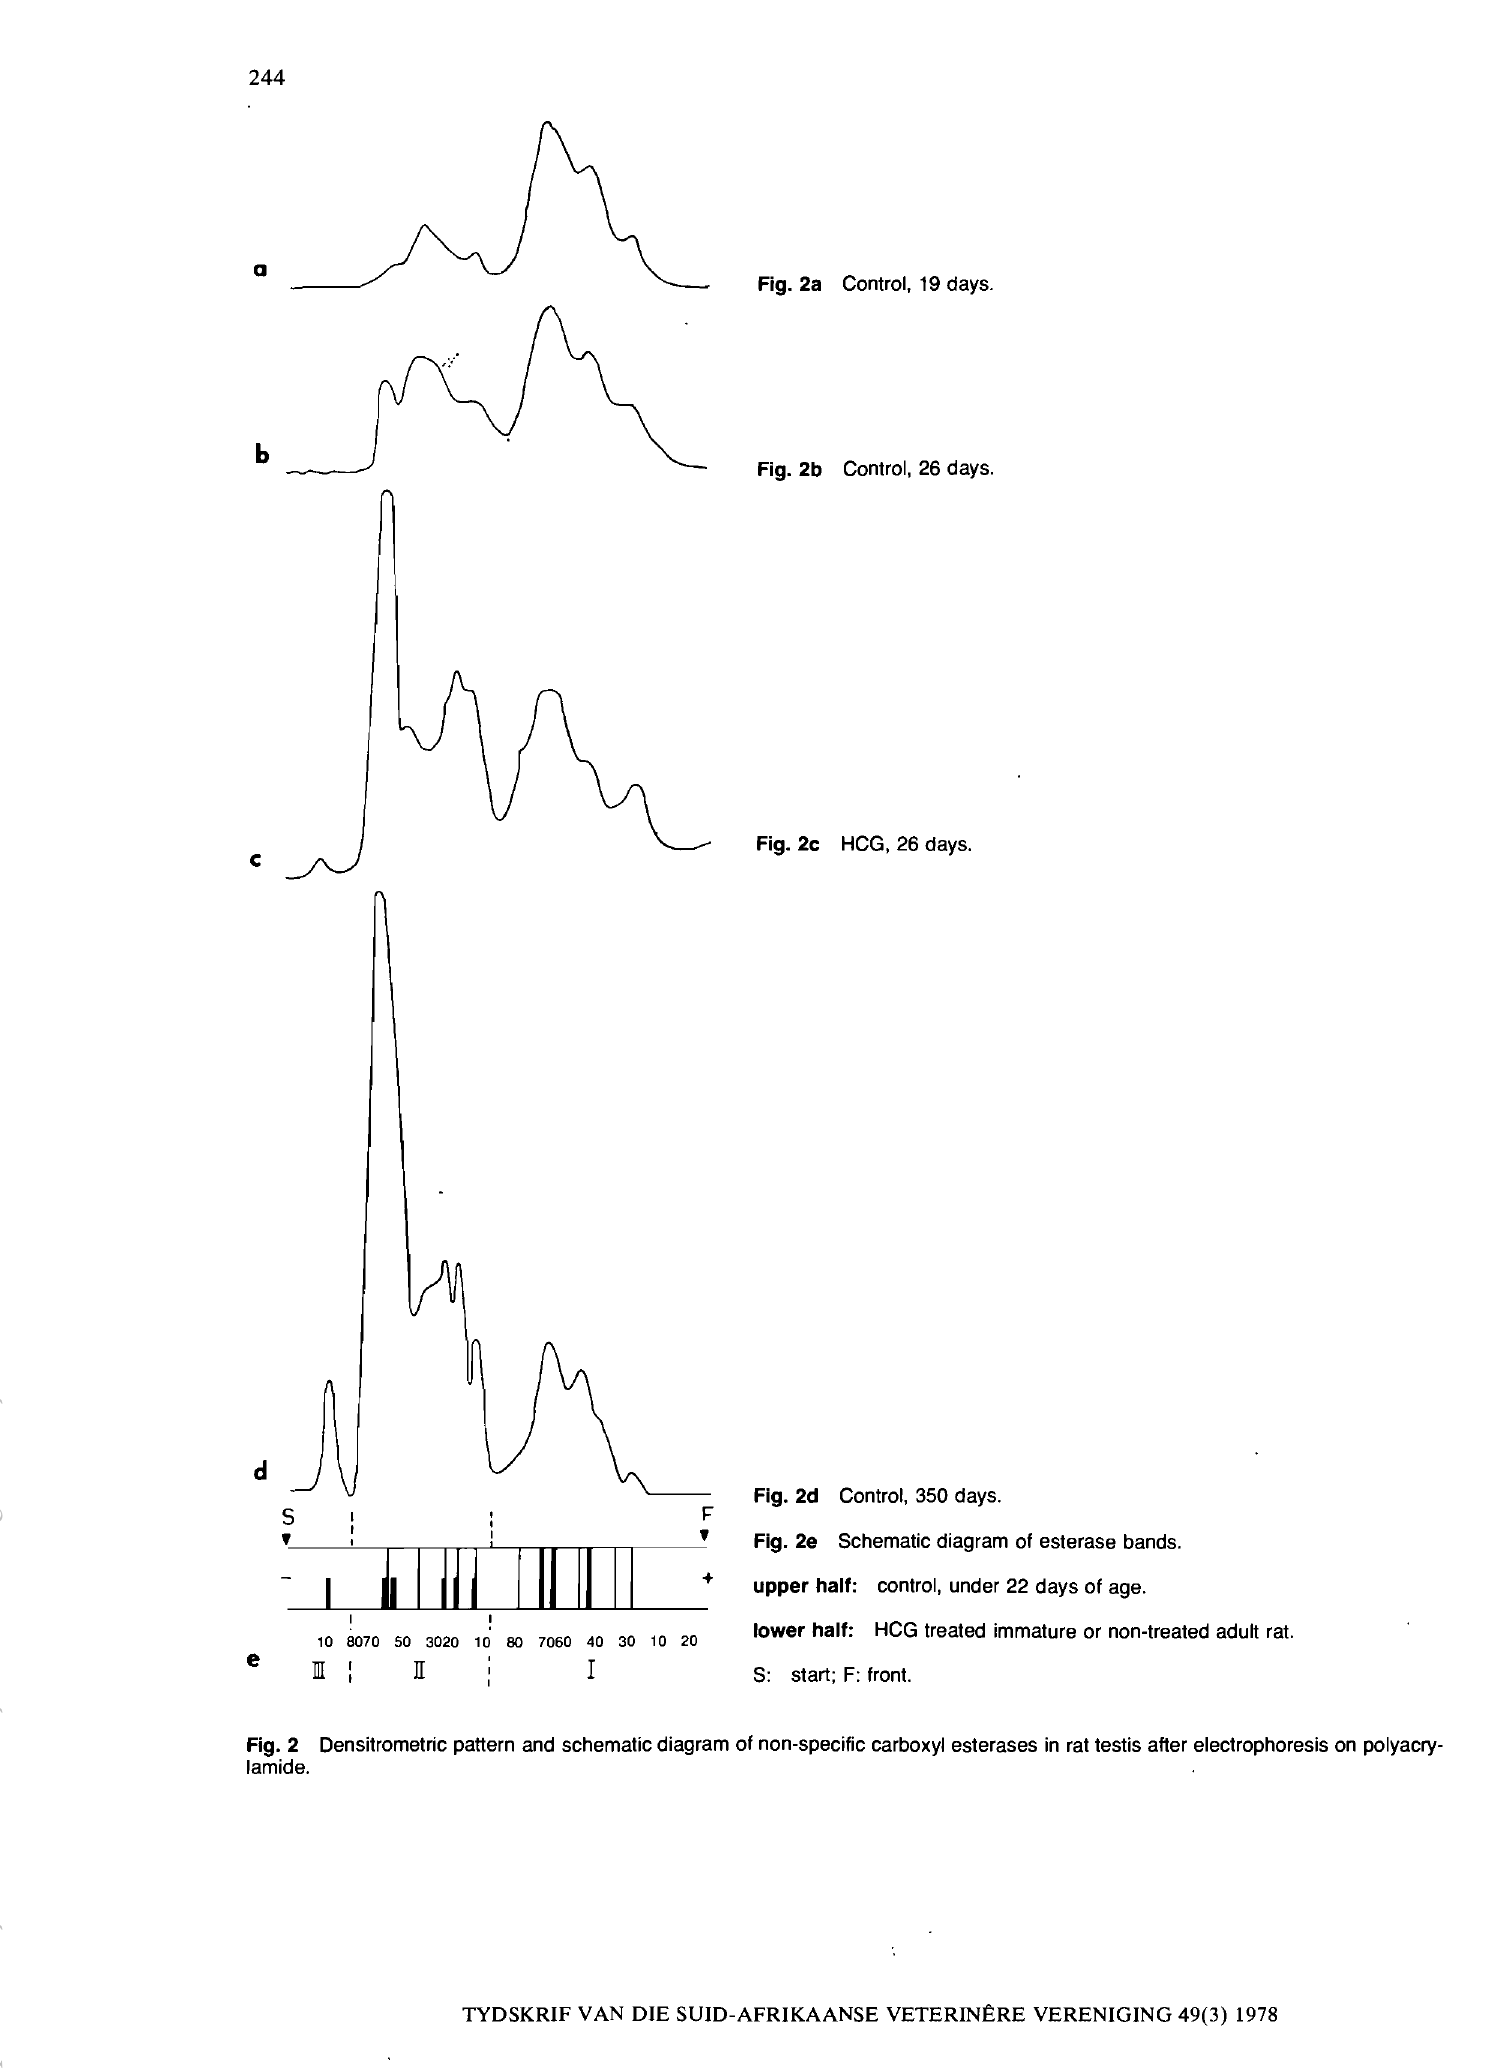
Fig. 2e Schematic diagram of esterase bands. upper half: control, under 22 days of age. lower half: HCG treated immature or non·treated adult rat.